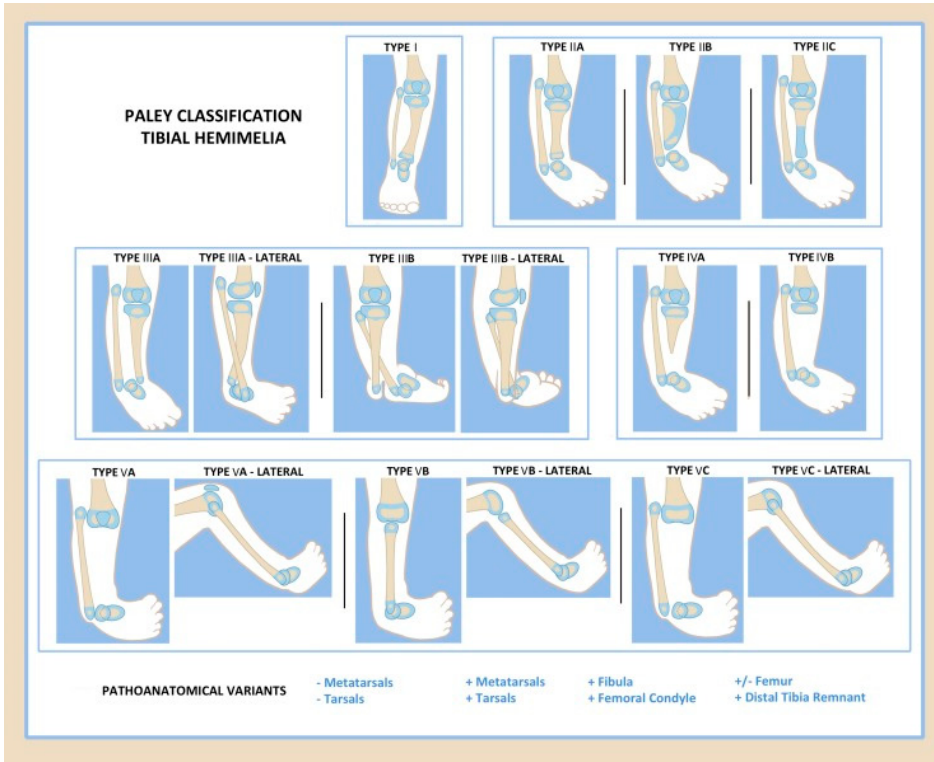
Figure 2. Paley classification of tibial hemimelia. Table 1. Paley classification of tibial hemimelia.